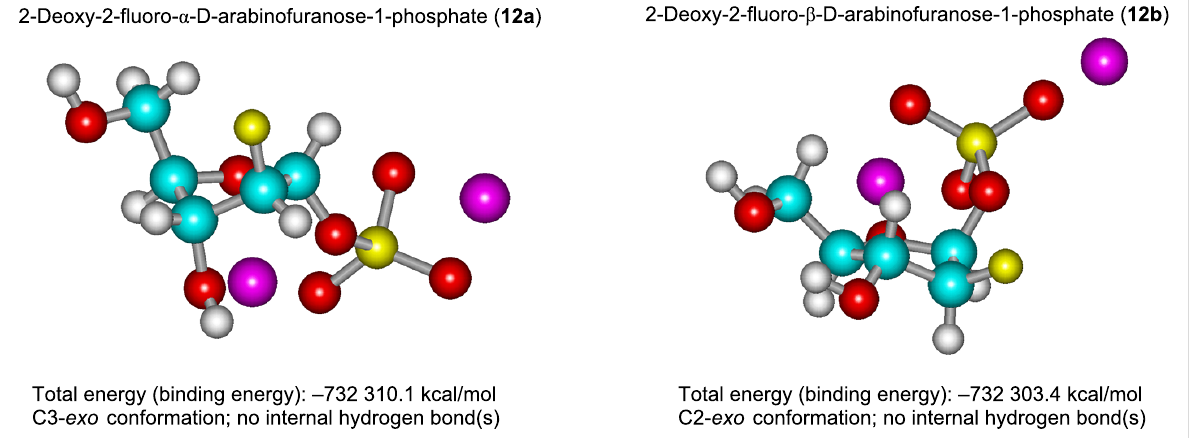
Figure 3: Geometry optimization of 1-phosphates of 2-deoxy-2-fluoro- α -D-arabinofuranose ( 12a ) and the β -anomer 12b [dilithium salts; HyperChem 8.1; AMBER Force Field starting approximation, then the ab initio calculations (3-21G/total charge equal to zero; Polak–Ribiere conjugate gradient)].